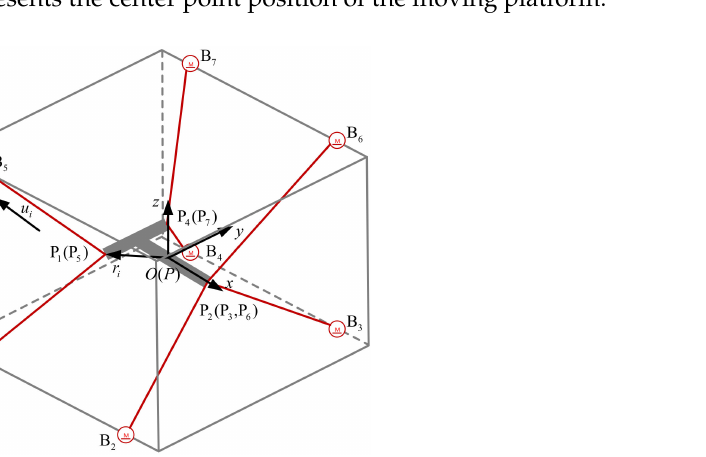
Figure 3. Parallel cable-driven upper limb rehabilitation robot (PCUR) mathematical